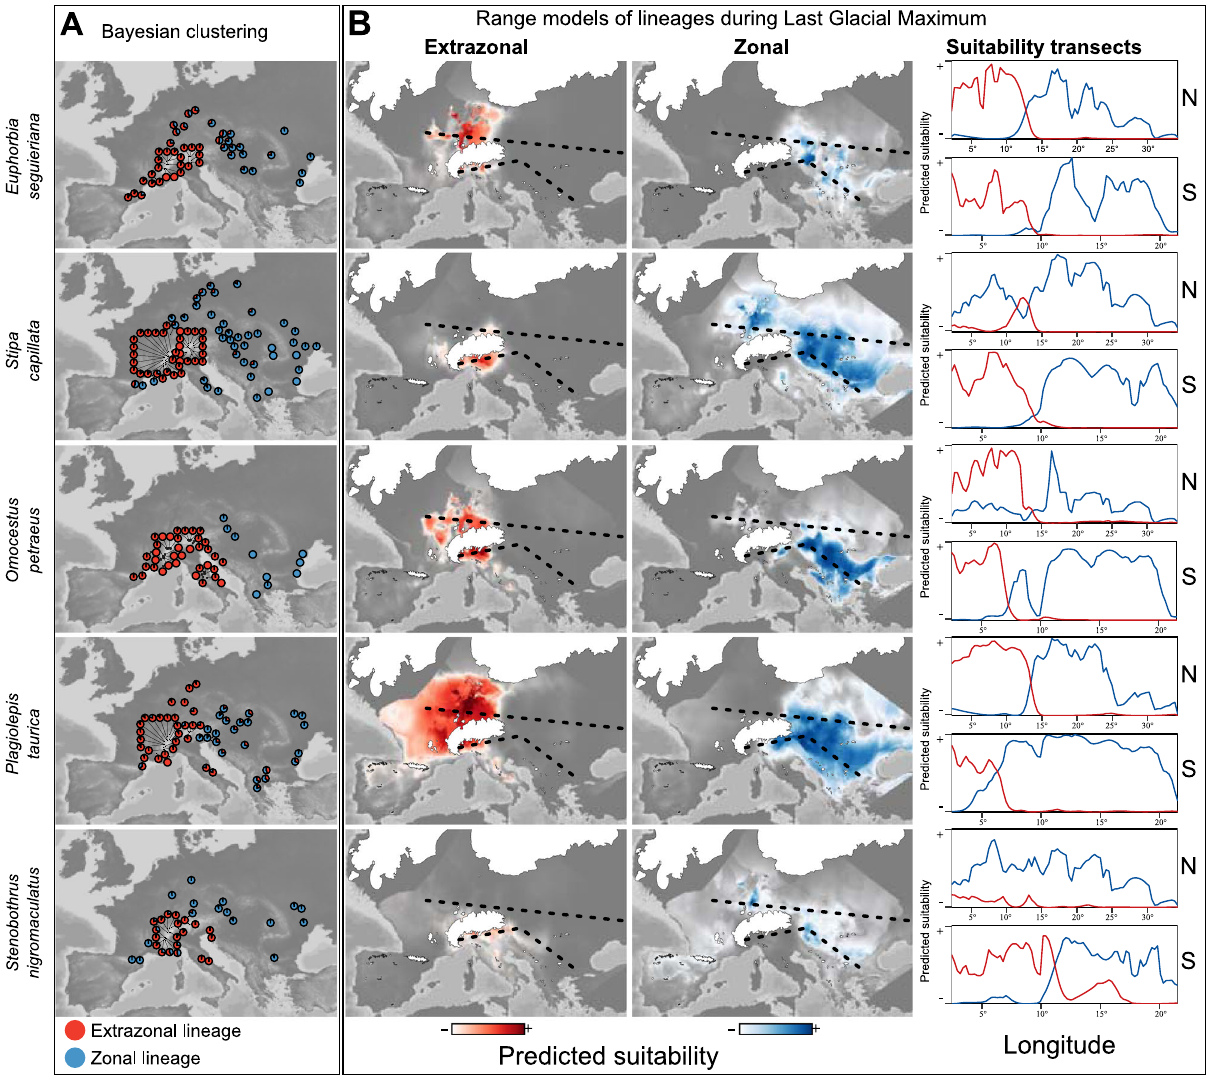
Fig. 2 Extant distribution of genetic lineages and modeled past ranges. A Distribution of extrazonal (red) and zonal (blue) lineages of steppe species based on genetic clusters inferred via Bayesian clustering. Each pie chart represents a population. B Distribution of predicted species-speci fi c habitat suitability (non-standardized) during the Last Glacial Maximum (21 kya) based on niche models using climatic variables. Suitability transects show predicted habitat suitability for the extrazonal lineage (red line) and the zonal lineage (blue line) along the dashed lines depicted in the maps; x -axes represent longitude; N, northern transect; S, southern transect. Source data are provided as a Source Data fi